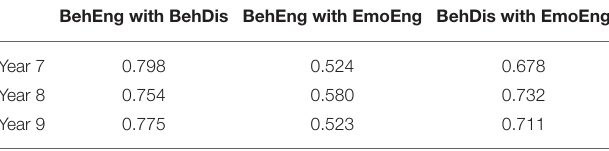
TABLE 8 | Model fit test statistics, fit indices, and their changes for the MI analyses for gender and ethnicity. Model fit test statistics and fit indices